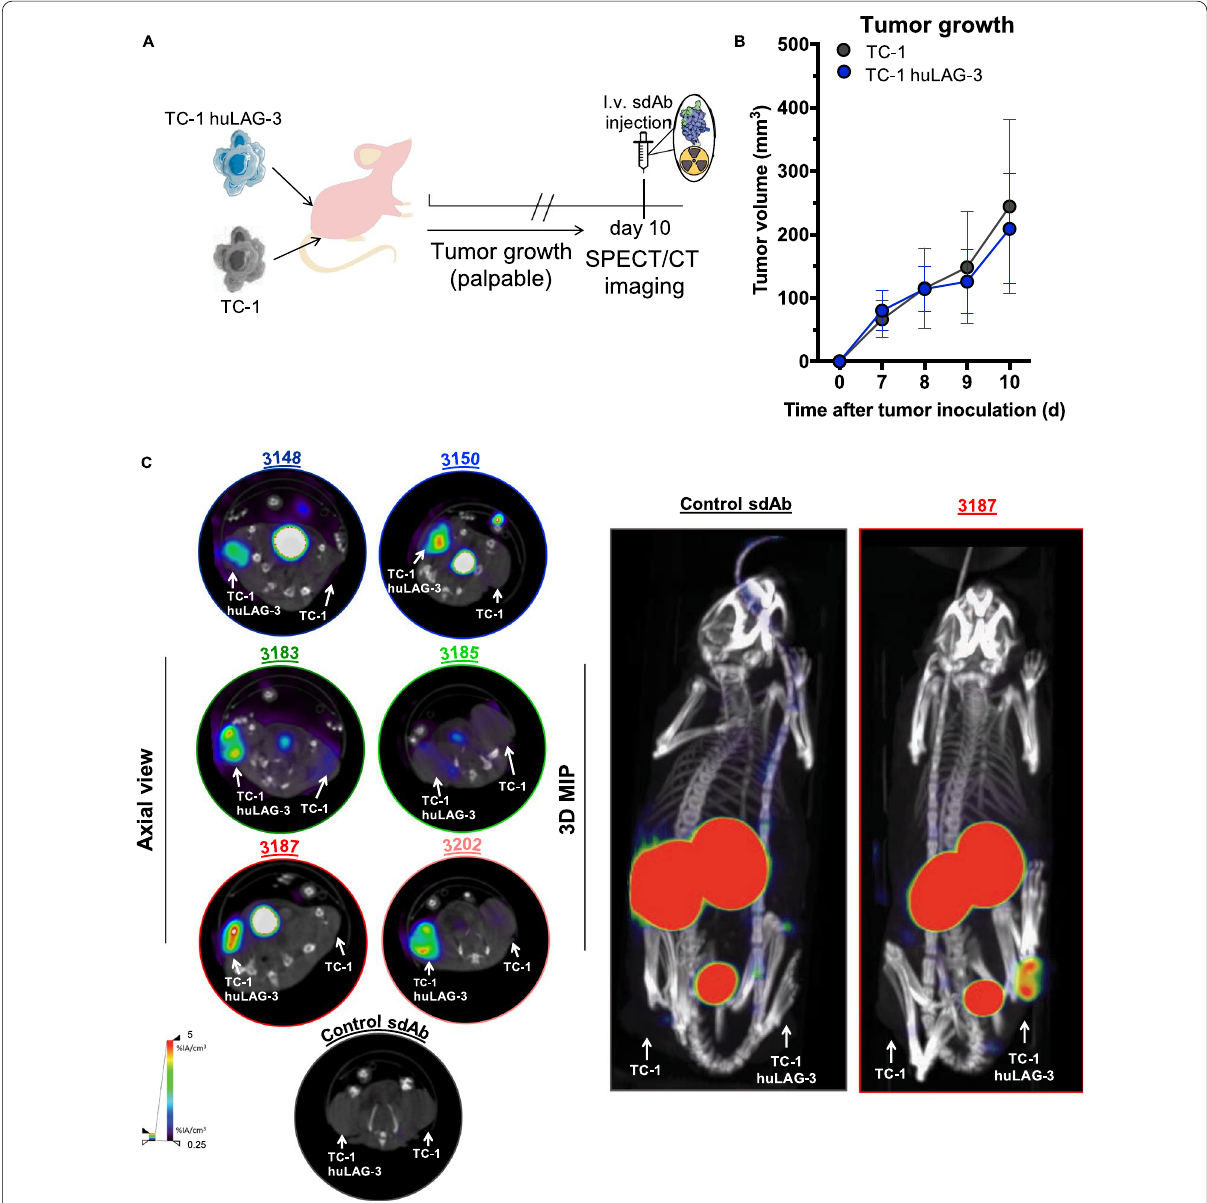
Fig. 5 Visualization of huLAG-3 in mice bearing TC-1 and TC-1-huLAG-3 tumors using SPECT/CT imaging. A Schematic representation of the study design. B TC-1 and TC-1-huLAG-3 cells were injected subcutaneously at opposite hind legs of NU(NCr)Foxn1nu mice and allowed to grow tumors up till day 10. The graph shows the tumor volume in function of time as mean evaluate the utility of selected 99m Tc-labeled sdAbs to detect huLAG-3 expressed in tumors. The arrows indicate the tumors on the images ( n